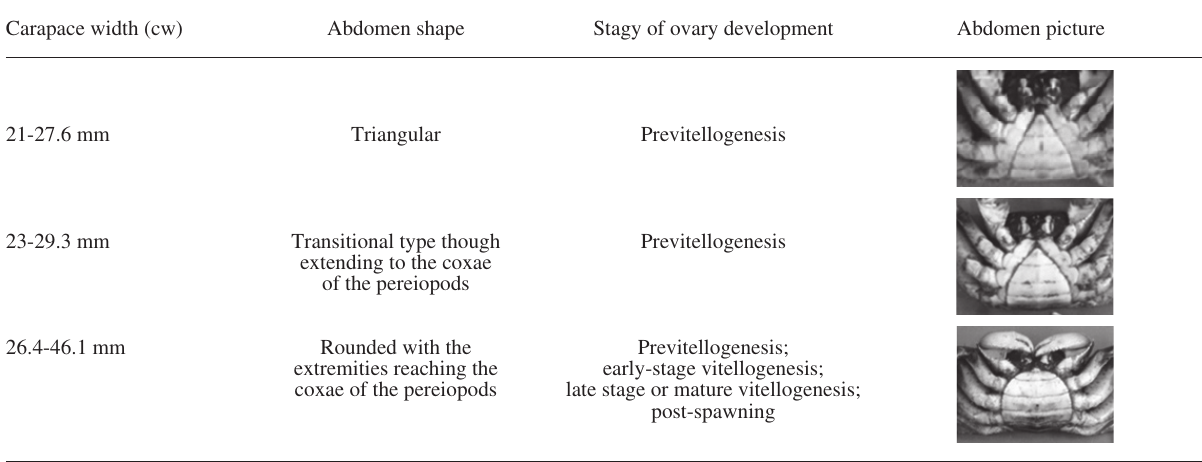
Table 2. – interrelation between ovary stages and abdomen shape in Goniopsis